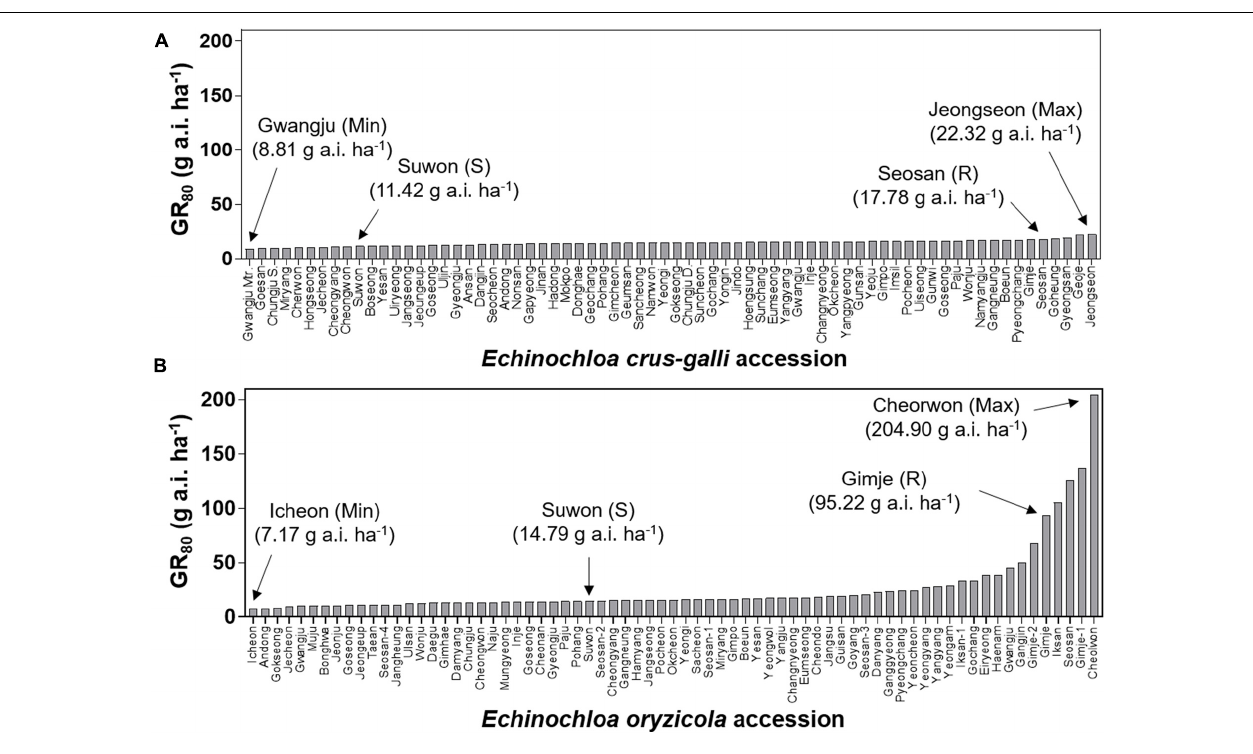
sensitivity of Echinochloa species to florpyrauxifen-benzyl ( Figures 5 , 6 ). The frequency distribution for the GR 50 and GR 80 values of E. crus-galli accessions followed a normal distribution